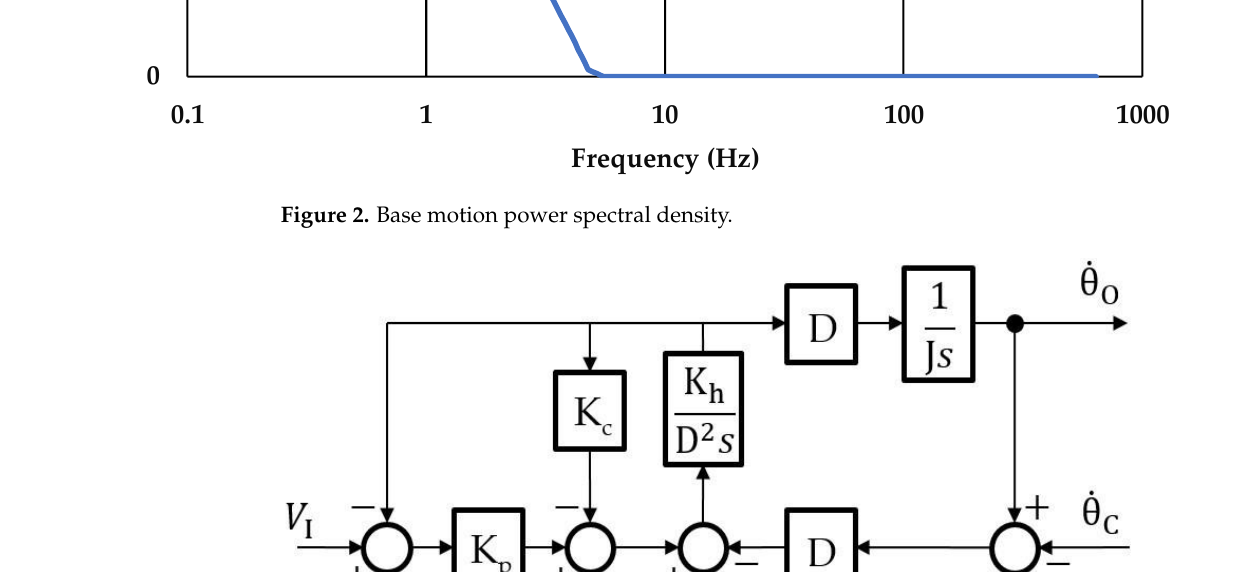
Figure 3. Hydraulically actuated stabilization system design [13] .